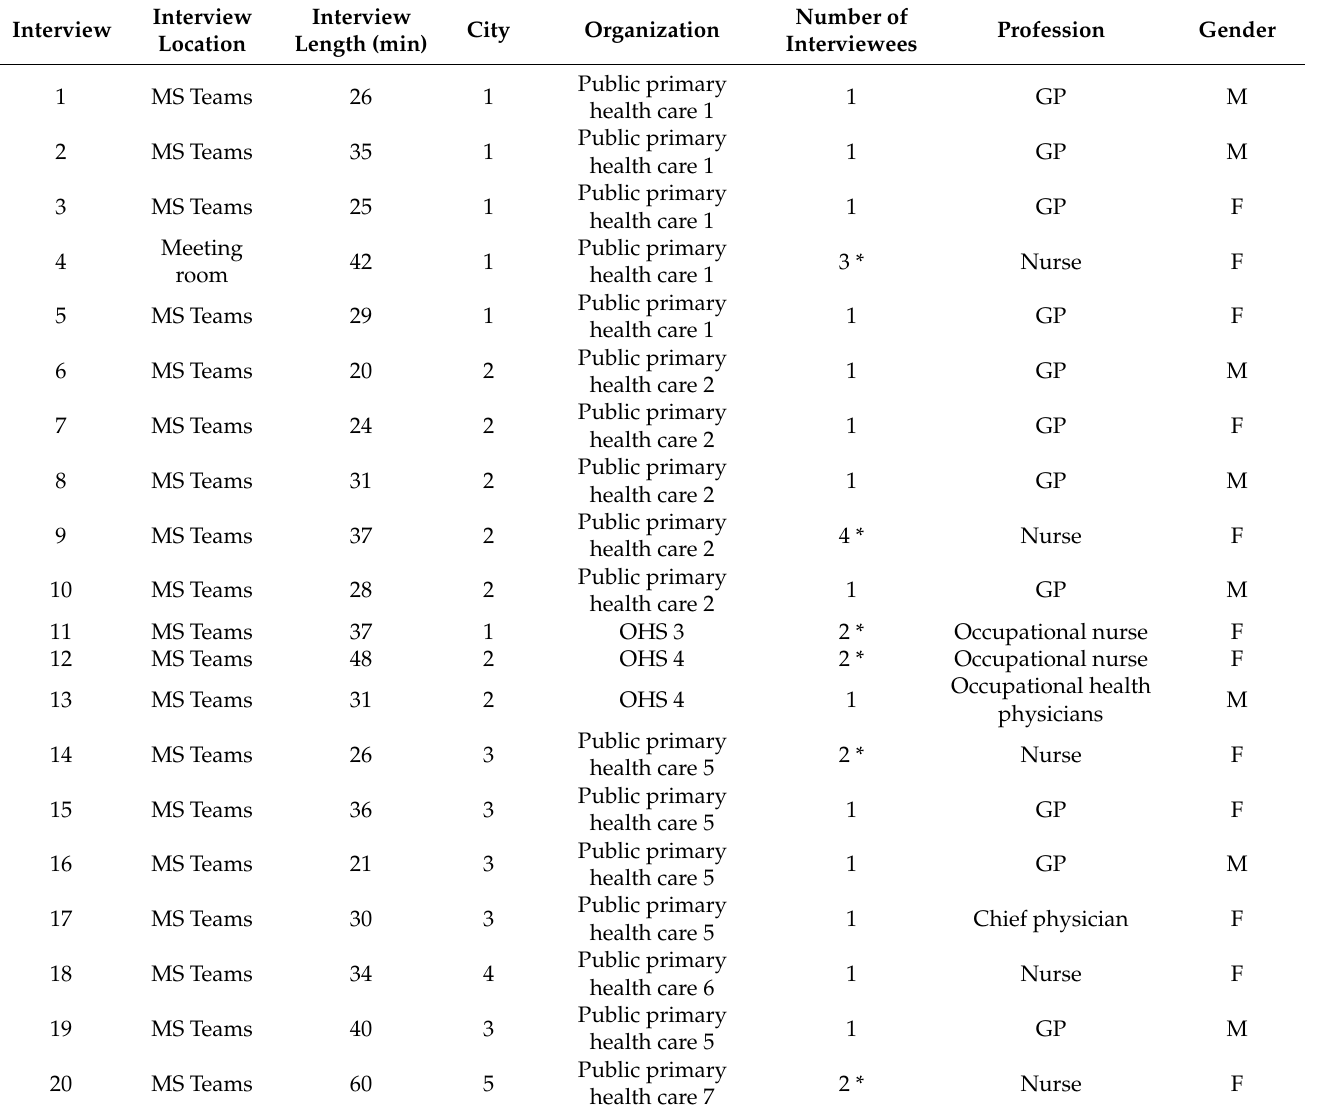
Table 1. Interviewees’ demographics and interview